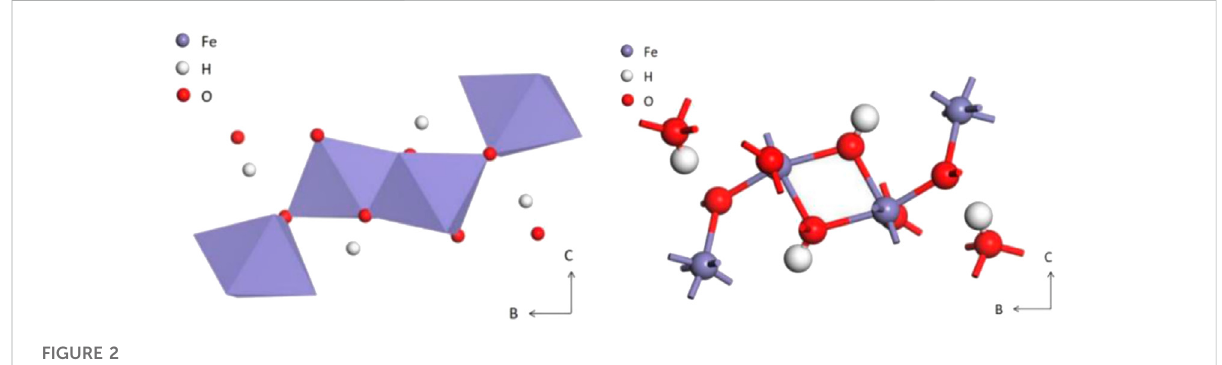
FIGURE 2 The ball and stick model of